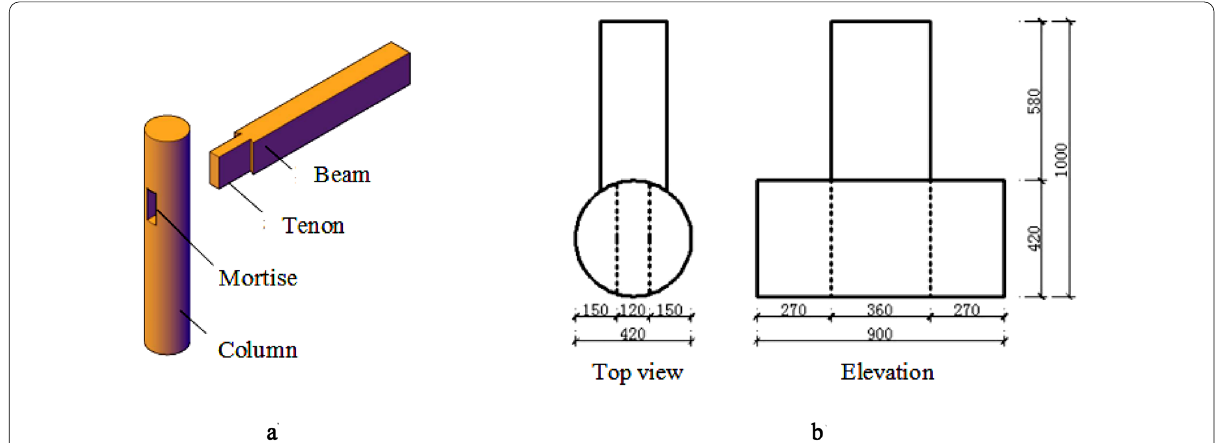
Fig. 20 Sizes of FEM: a construction of straight tenon joint; b the detailed dimensions (unit: mm) [37]